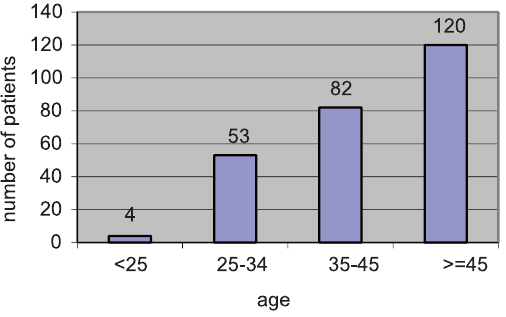
FIGURE 1. Age groups in the sample. By age categories the analysis included 4 (1.5%) patients in the group <25 years, 53 (20.5%), in the category of 25-34 years, 82 (31.7%) category 35-45 years and group > = 45 years 120 (46.3%)